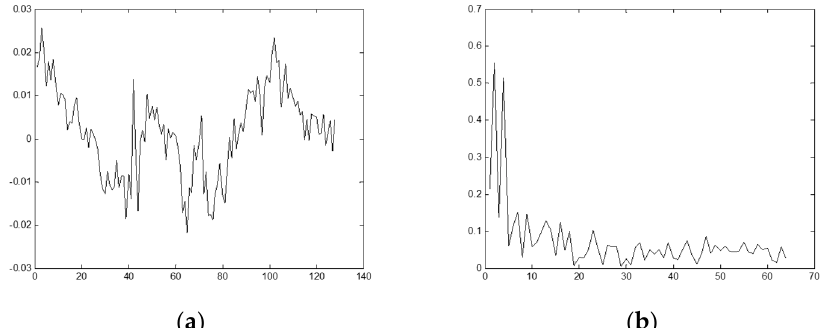
Figure 16. Mechanical drilling signal recognized as walking signal. ( a ) Time domain; ( b ) Frequency domain.